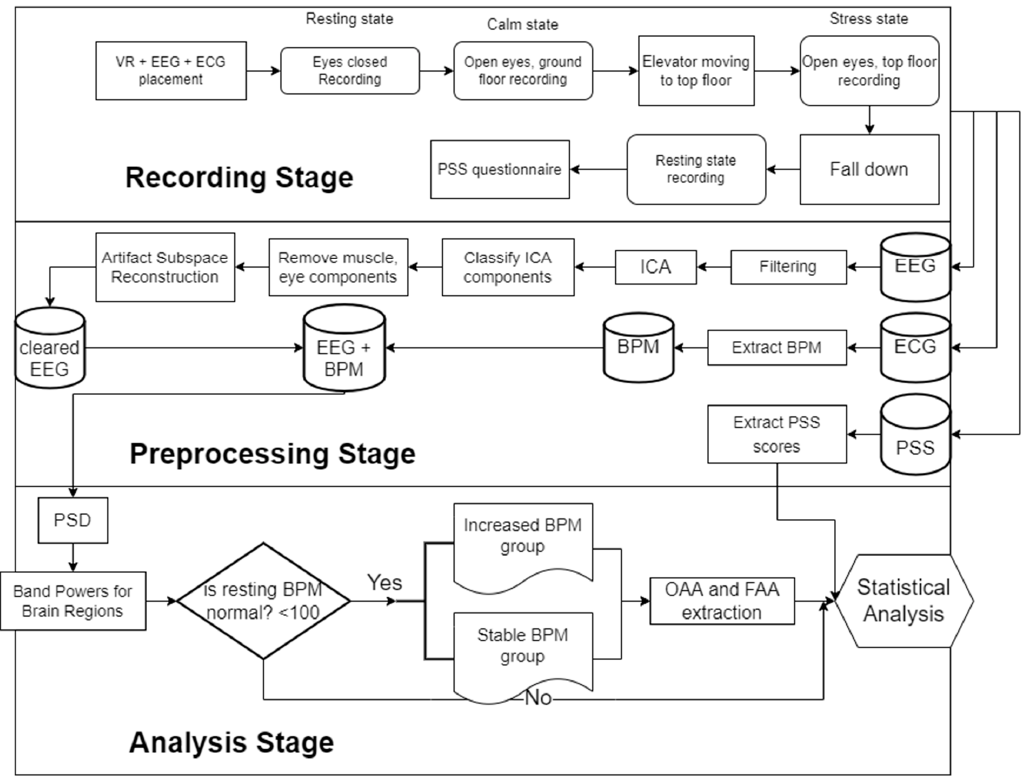
Figure 1. Flowchart of the experiment.